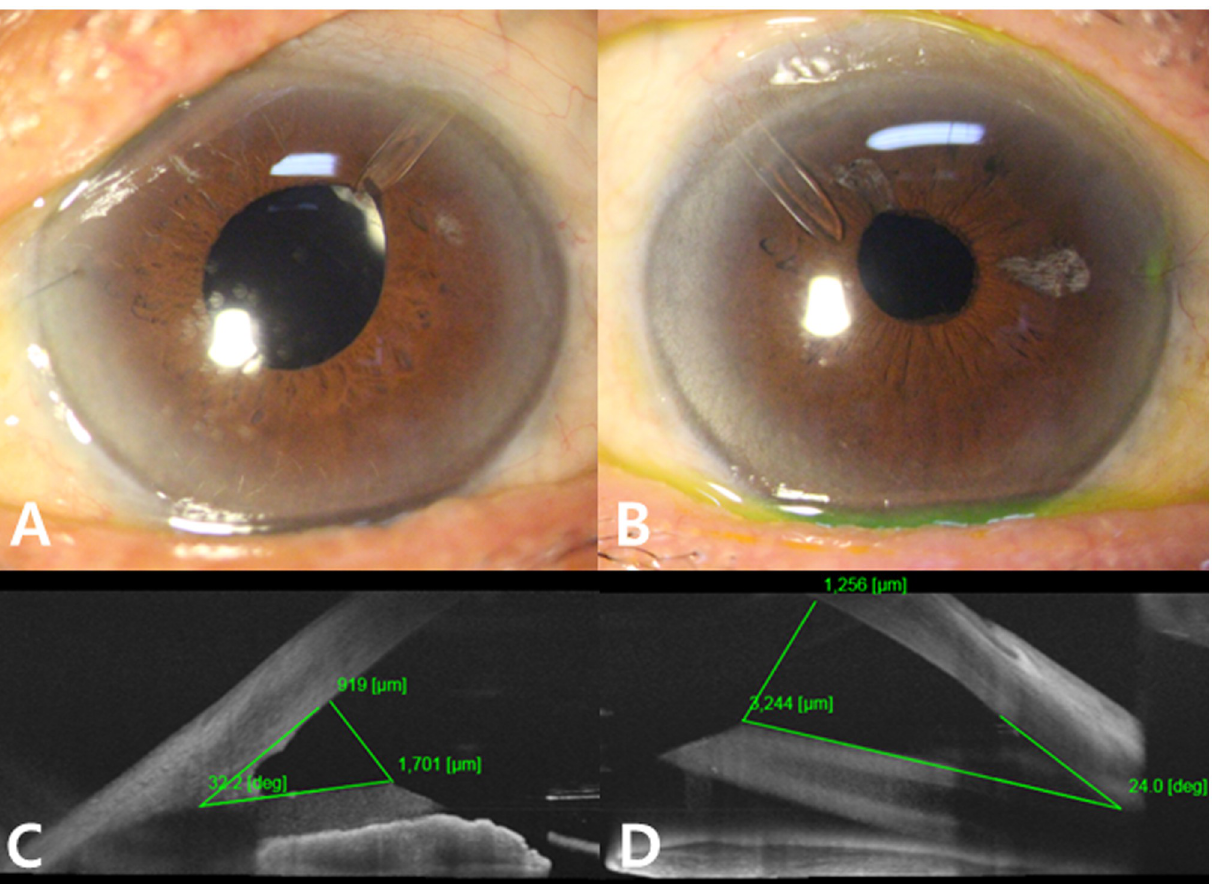
Fig 3. Representative cases from the gAGV and ngAGV groups. Slit-lamp photographs and AS-OCT imaging of two representative cases from the gAGV (A, C) and ngAGV (B, D) groups. AS-OCT shows the tube on the left (C) with a greater TCA and TCD than the tube on the right